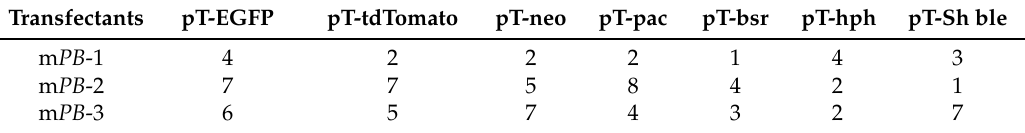
Table 2. Estimation of the copy number of transgenes in the PEF transfectants 1 .